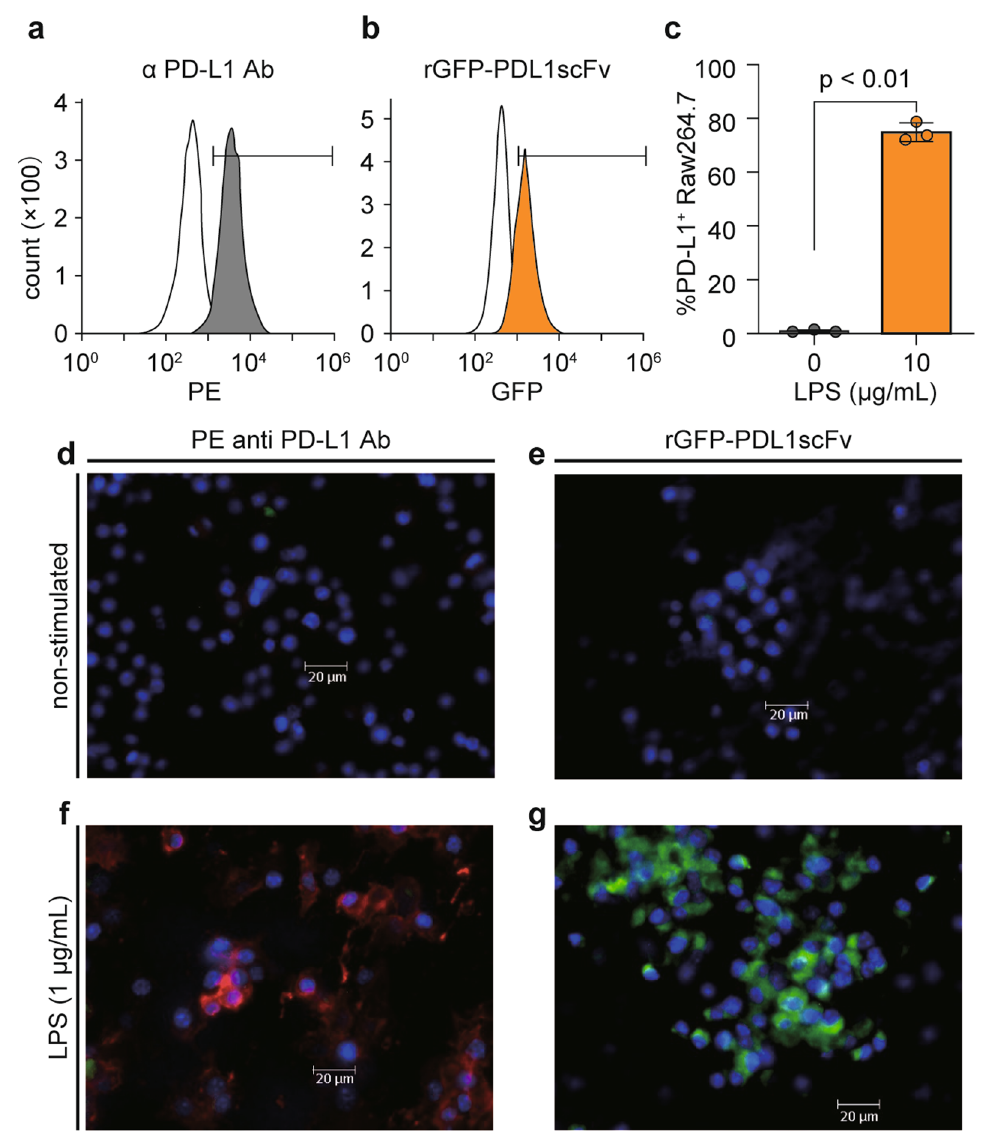
Fig. 5 Cell surface antigen recognition ability of rGFP-PDL1scFv. Raw264.7 cells (2.0 10 6 cells/well) were stimulated with lipopolysaccharide (LPS) × (1 or 10 µg/mL) and stained using PE anti-mouse PD-L1 antibody or purified rGFP-PDL1scFv. Then fluorescence was detected by flow cytometry ( a‑c ) and fluorescence microscopy ( d‑g ). Representative flow cytometry histograms of staining with PE anti-mouse CD274 (B7-H1, PD-L1) antibody ( a ) or rGFP-PDL1scFv ( b ) are shown, respectively. Each white histogram indicates non-stimulated Raw264.7 cells. Gray histograms indicate LPS-stimulated Raw264.7 cells, and orange histograms indicate LPS-stimulated Raw264.7 cells. Black bars indicate the gated region used to calculate PD-L1-positive cells. c The graph shows the measurement results for the gated positive cell ratio in the stimulated or non-stimulated Raw264.7 cells stained with rGFP-PDL1scFv. Data are the mean SD (n 3), and each dot on the plot represents one experiment. Representative fluorescence ± = microscopy images of Raw264.7 cells stimulated with LPS ( f , g) or without LPS ( d , e) and stained with DAPI and PE anti-mouse CD274 (B7-H1, PD-L1) antibody ( d, f ) or rGFP-PDL1scFv ( e, g) are shown (blue: DAPI, red: PE, green: GFP). Scale bar 20 =